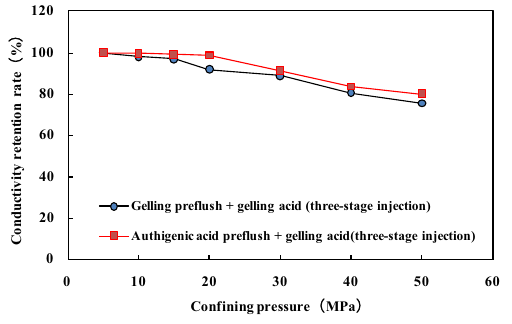
Fig.4 Changes in conductivity of two different liquid combinations under different closing